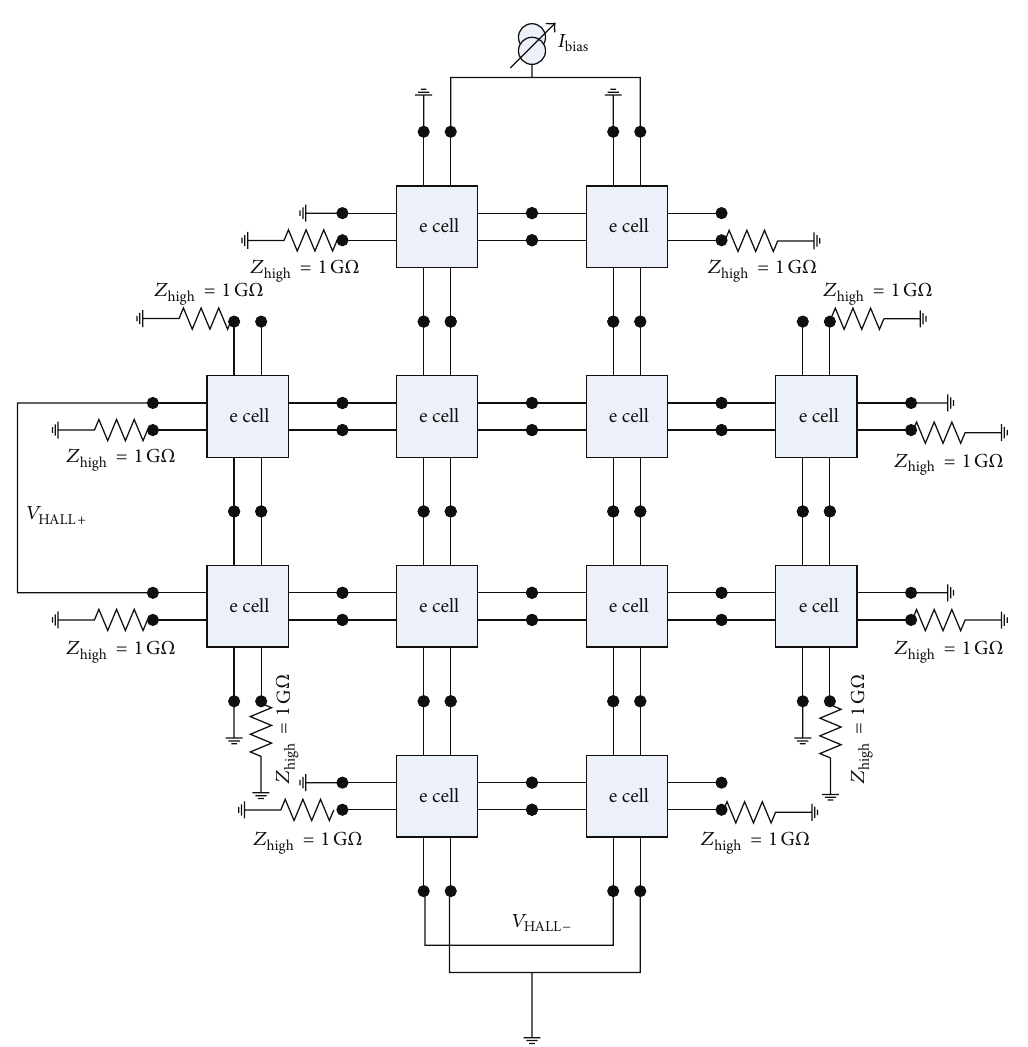
Figure 5: The XL cell representation by FEM model.